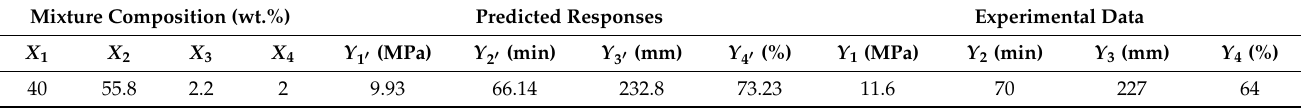
Table 3. Optimized mixture composition and results of prediction and validation